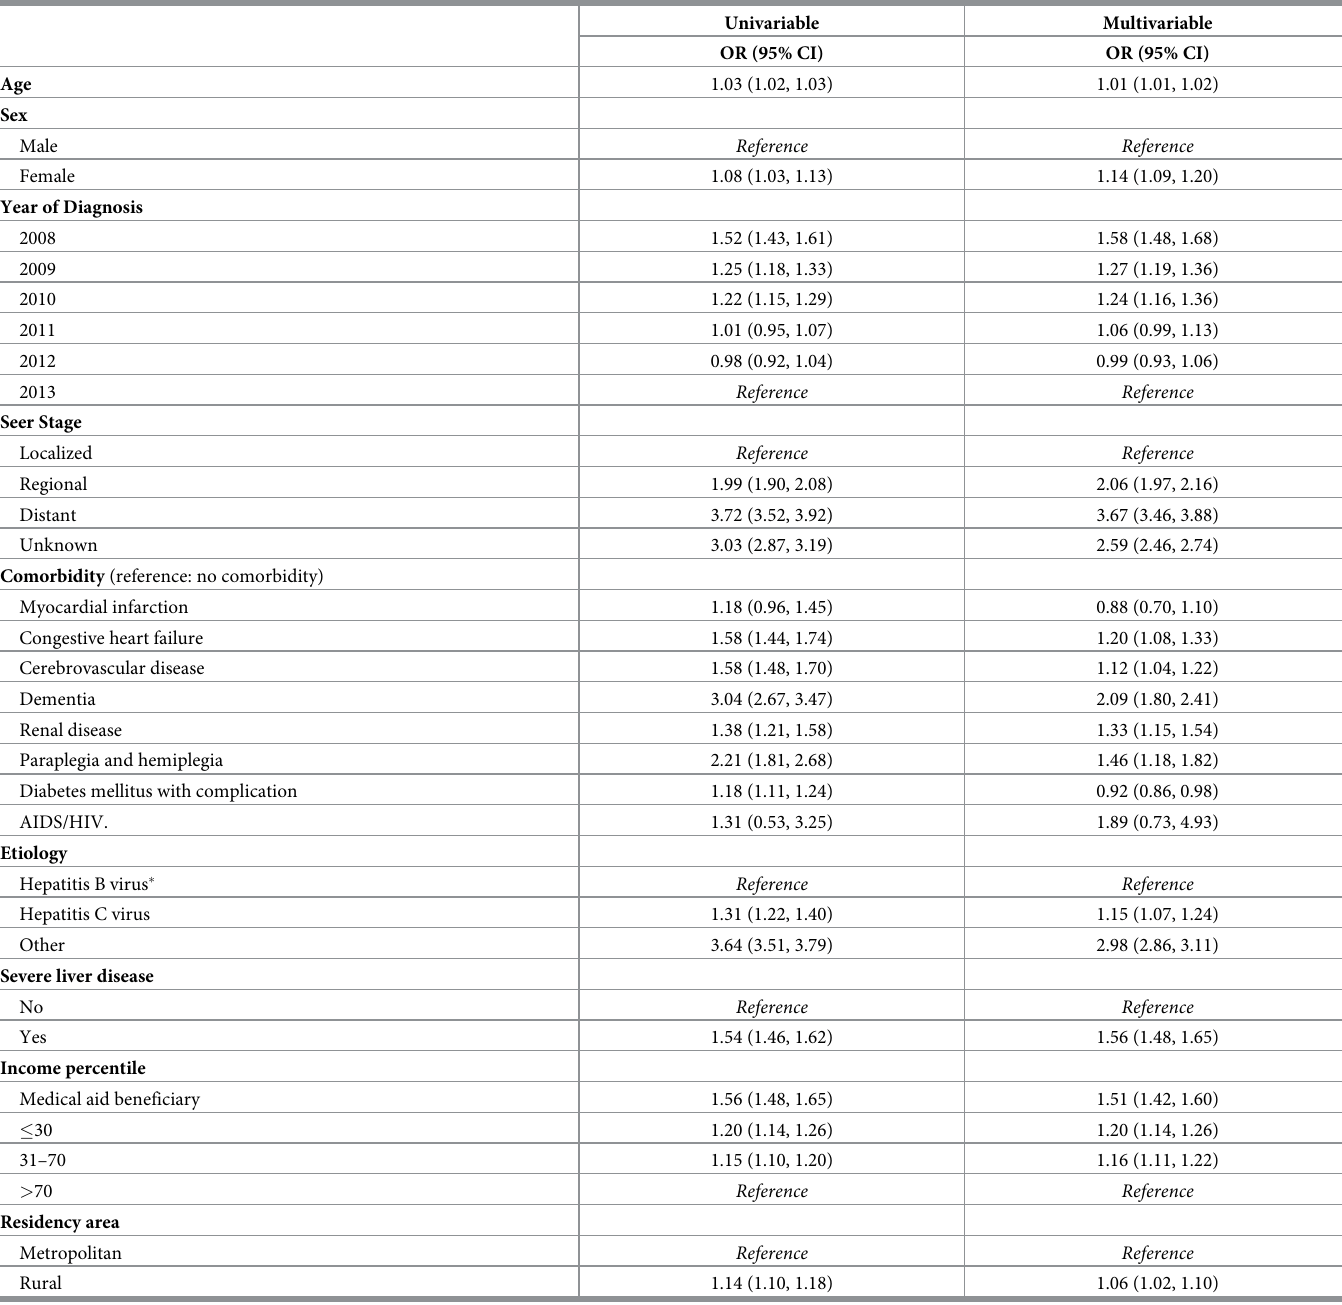
Table 2. Odds ratios (95% confidence interval) for factors associated with no treatment in patients with newly diagnosed hepatocellular carcinoma.